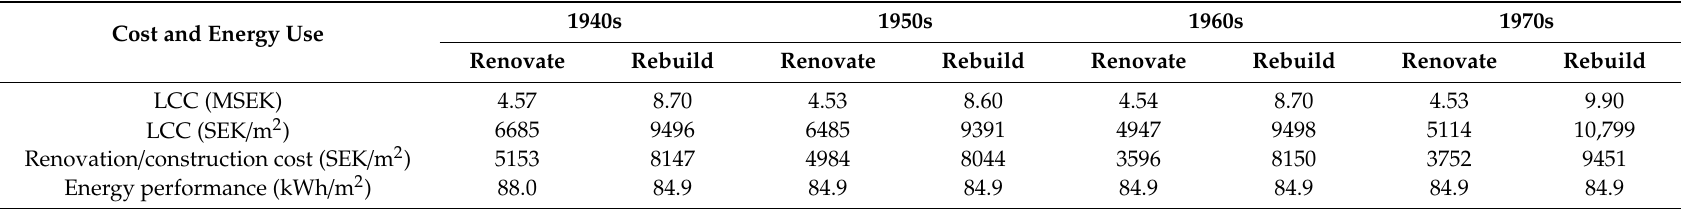
Table 19. Total LCC, LCC per apartment area, and renovation or construction cost per apartment area for the construction of a new building and renovation to the same energy performance as a new building (presented in Table